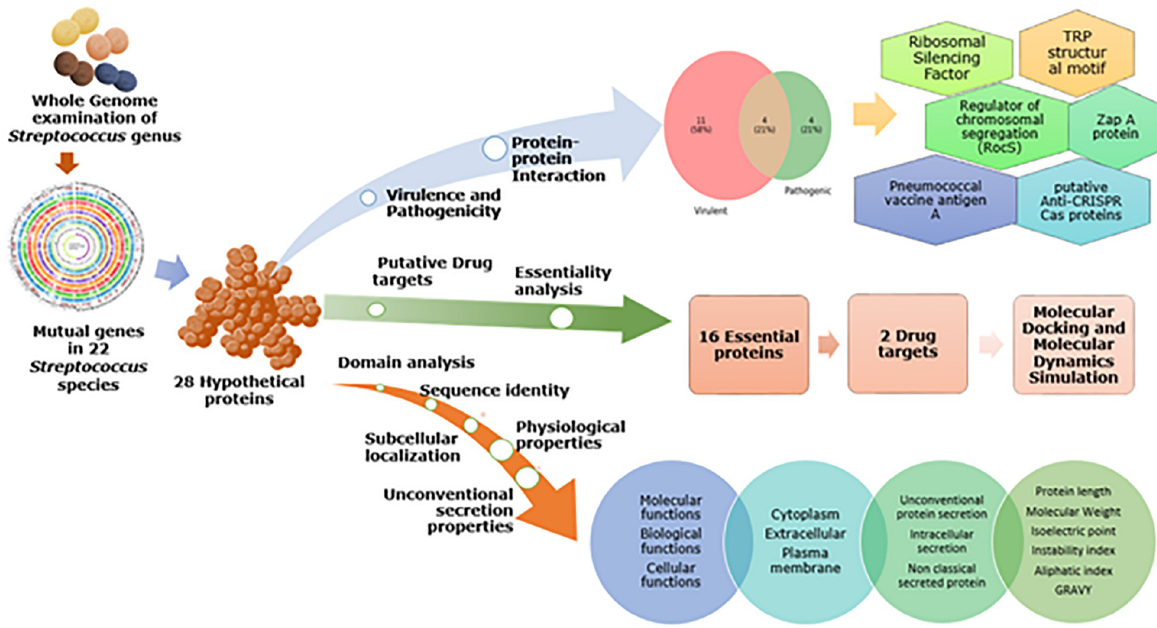
Fig 1. A schematic representation of the workflow involved to identify potential anti-streptococci drug targets.